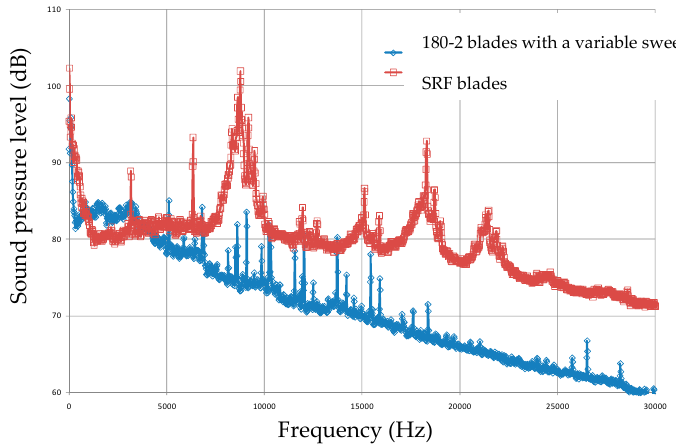
Figure 26. Acoustic spectra for model fans with straight and swept rotor blades. The C-3A test facility with the anechoic chamber 120°.